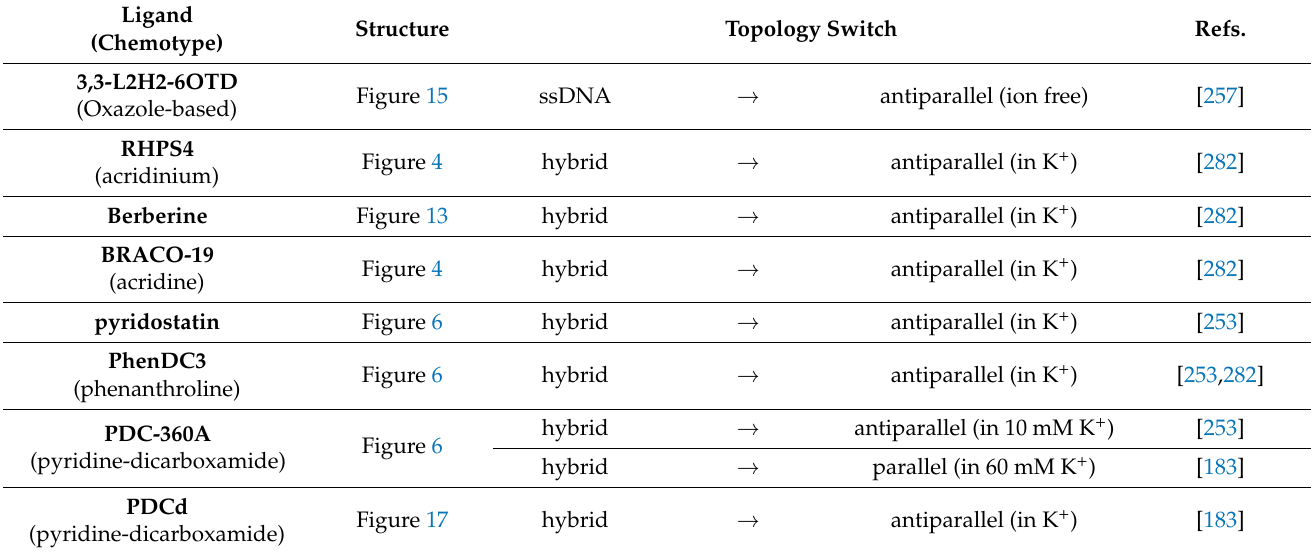
Table 7. Other G4 ligands inducing topological